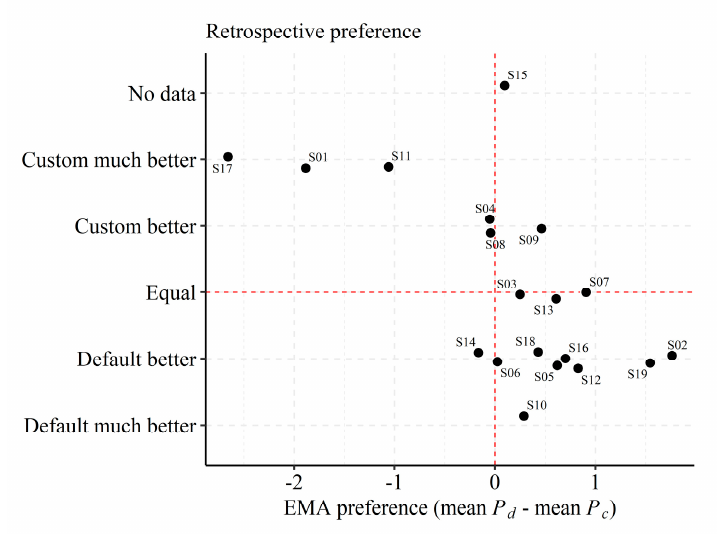
Figure 4. Retrospective preference against in situ EMA preference. EMA preference is represented by the difference in overall in situ rating of the default (P d ) and custom (P c ) listening program estimated from EMA responses. A positive x-value indicates a preference for P d and a negative x-value indicates a preference for P c . Retrospective responses from subject 15 are missing. Note that